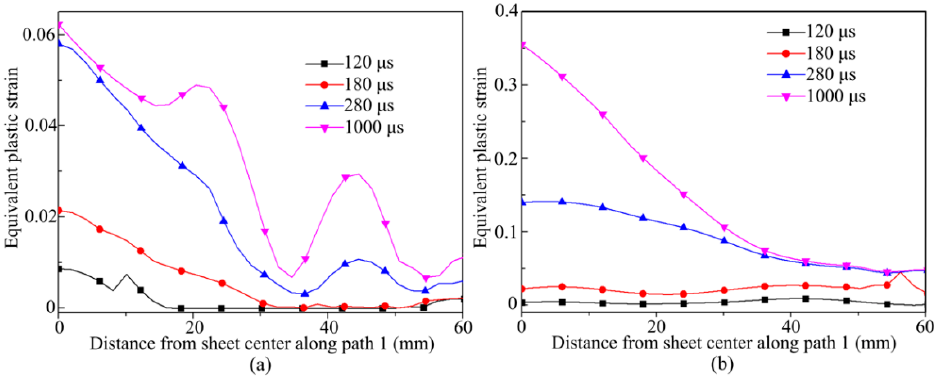
Figure 12. Equivalent plastic strain of sheet material at different time points during the forming process at different temperatures: ( a ) 200 °C; ( b ) 400